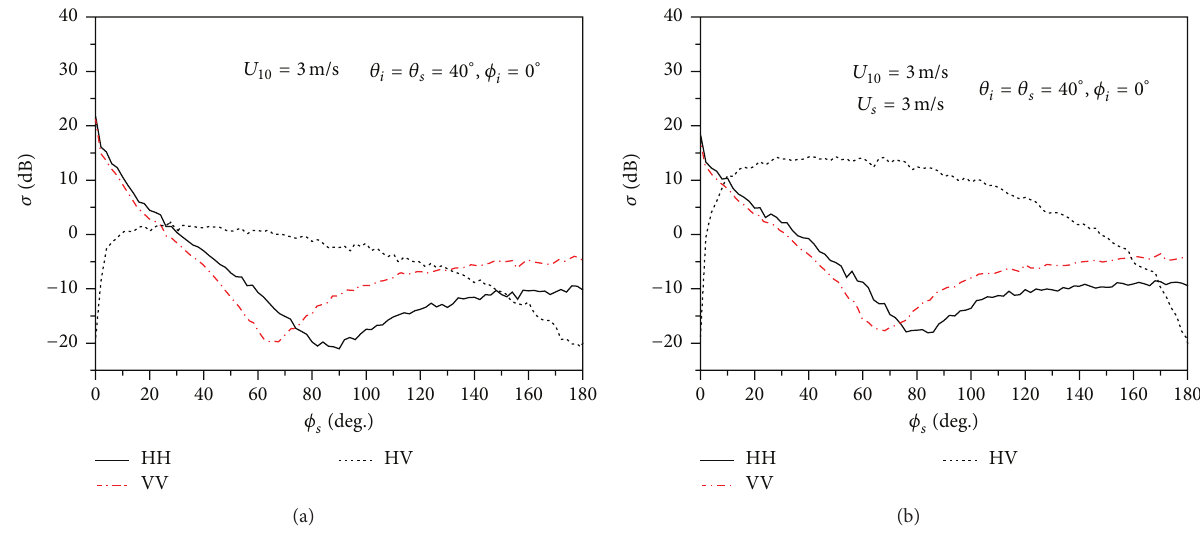
Figure 16: Similar to Figure 15, but with incidence angle 𝜃 𝑖 = 40 ∘ and scattering angle 𝜃 𝑠 = 40 ∘ . (a) Sea surface alone at wind speed 𝑈 10 = 3 m/s and (b) sea surface with ship wake at wind speed 𝑈 10 = 3 m/s and ship speed 𝑈 𝑠 = 5 m/s. approximation. Comparing Figure 15(a) with Figure